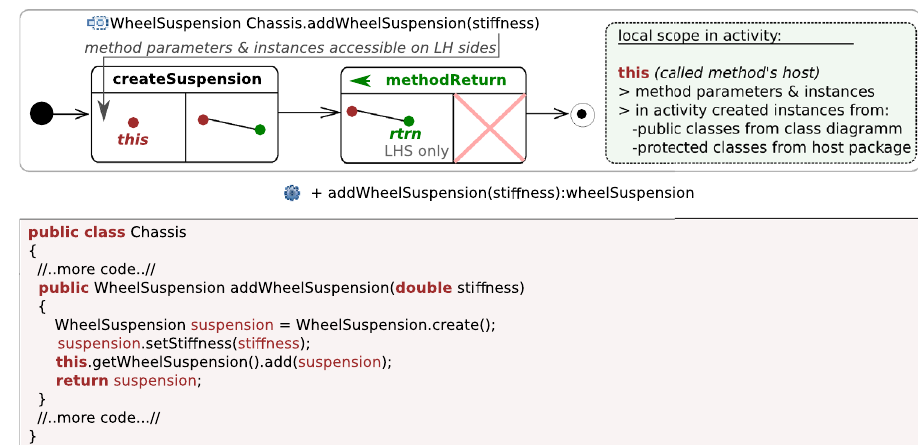
Fig. 9 Duality of method modeling: Either graphical implementation of method addWheelSuspension (method call in Fig. 8) as sub activity (top). The method’s return instance or value is specified in a LHS search context which is the sub activity’s final element. Or the method is